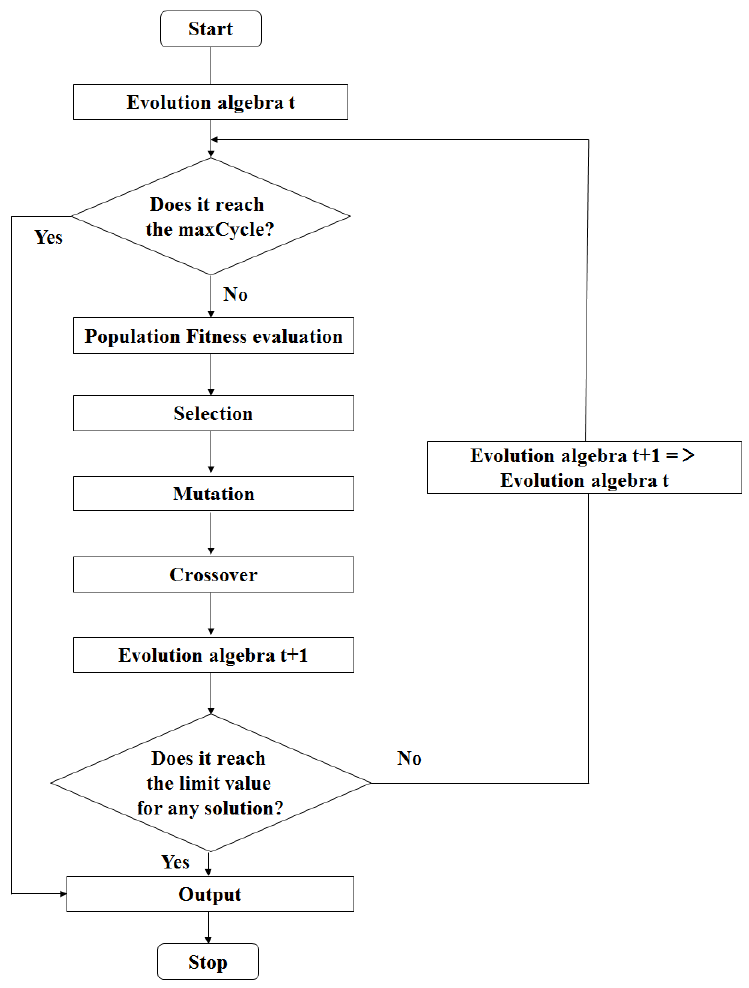
Figure 1. Flowchart of GA algorithm.